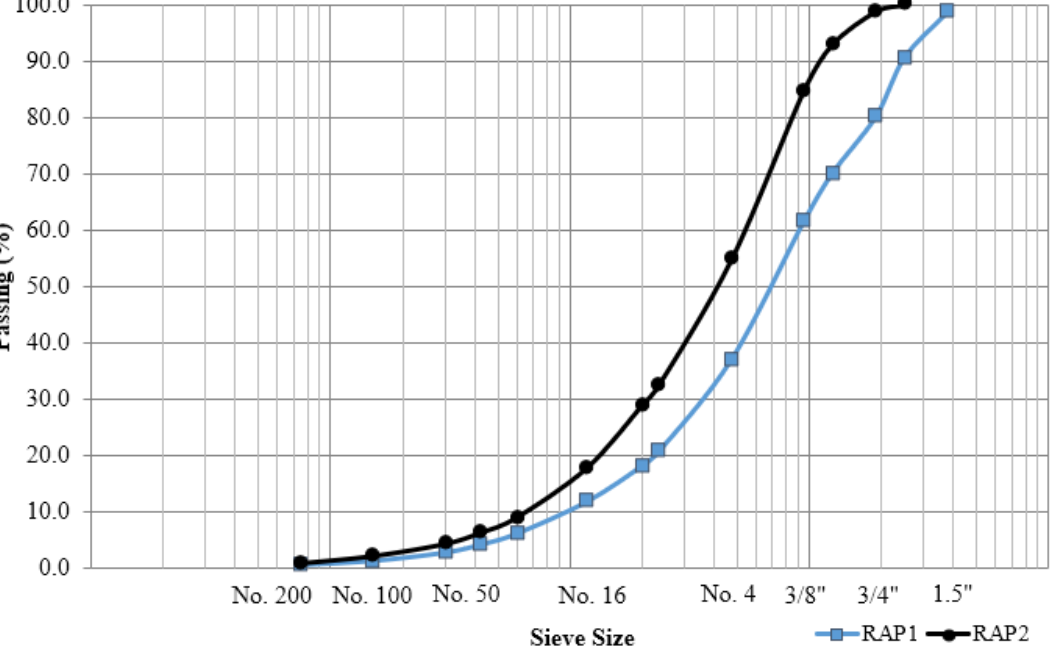
Figure 7. Gradation plots for both RAP sources.